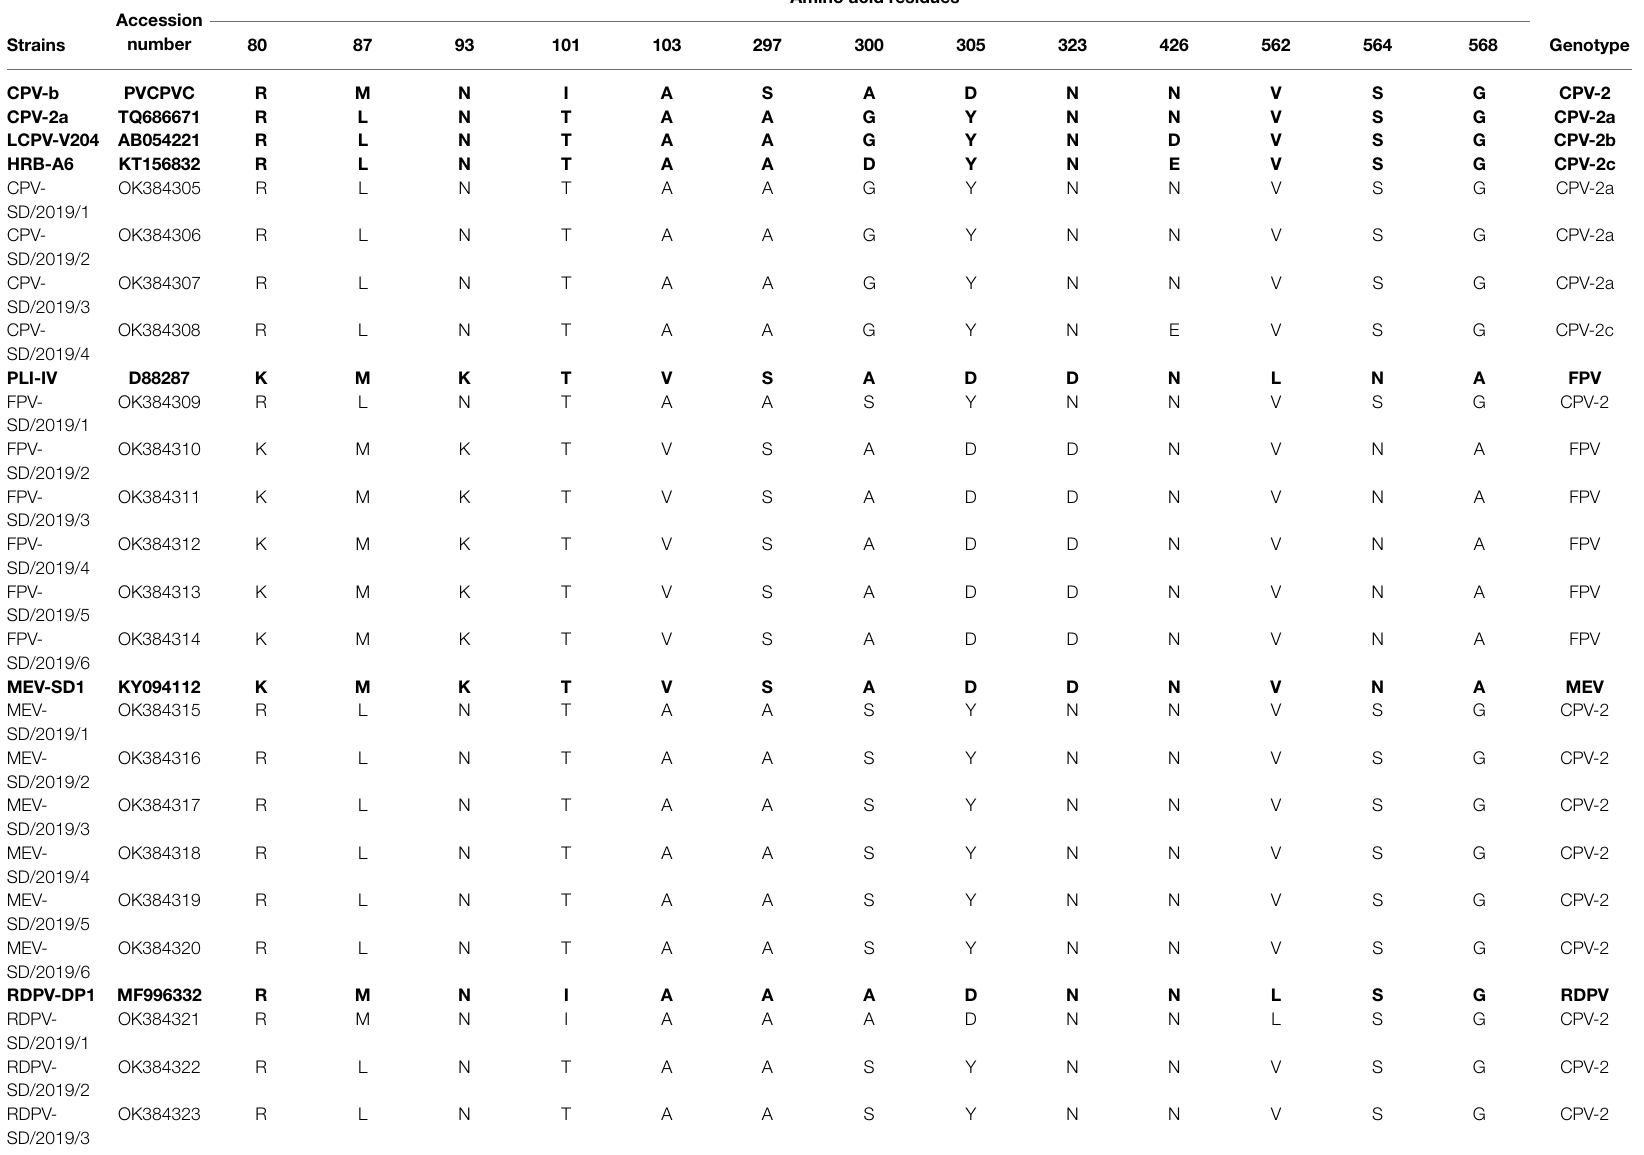
TABLE 4 | Amino acid sequence variations in the VP2